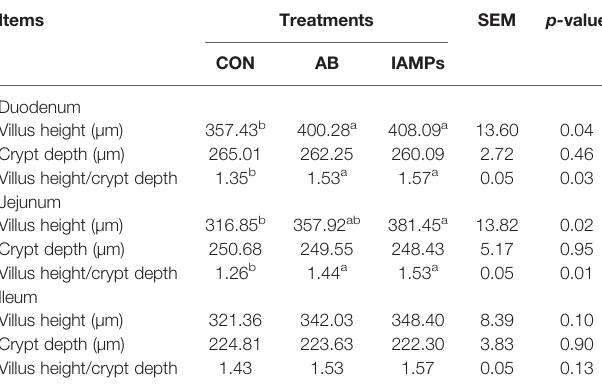
TABLE 7 | Effects of IAMPs on intestinal morphology of weaning piglets. Items